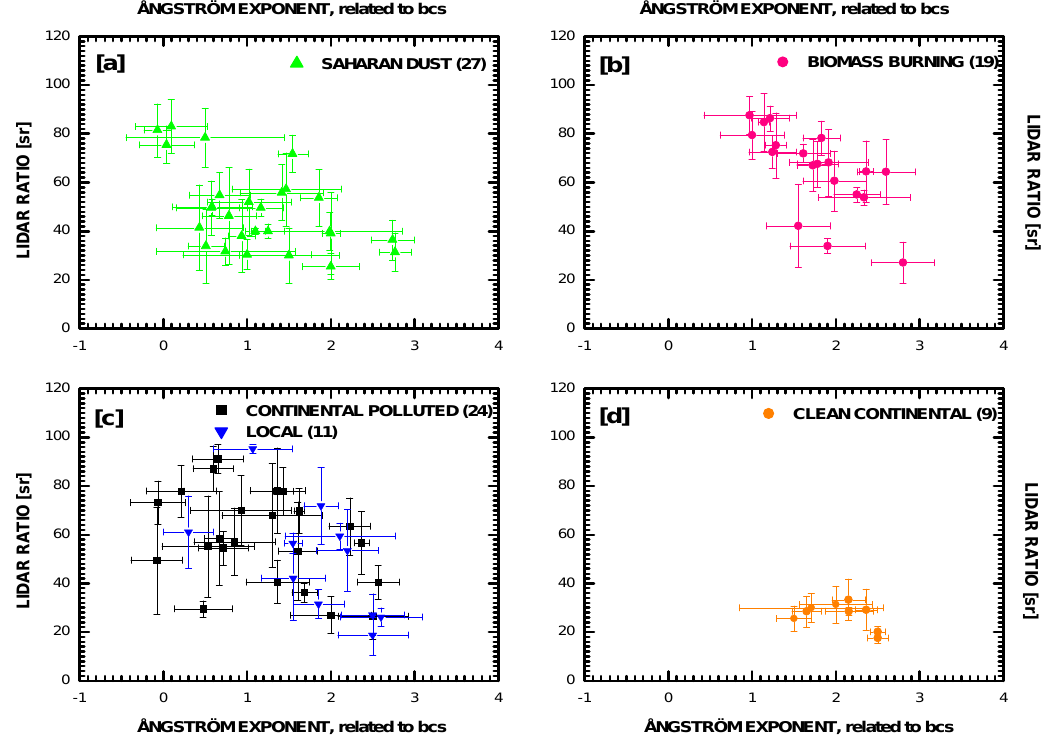
Fig. 3. Vertical mean values of the lidar ratio at 355nm versus the backscatter-related ˚Angstr¨om exponent, for different aerosol categories: (a) Saharan dust, (b) biomass burning, (c) local and continental-polluted and (d)